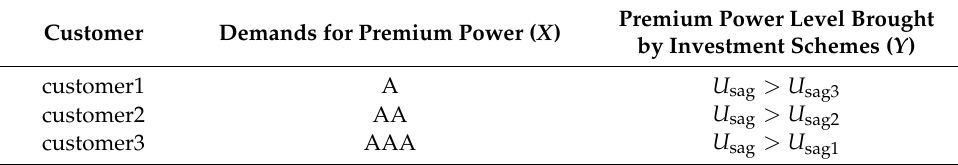
Table 1. The relationship between sensitive customers’ (SCs’) demands, and the premium power level. Customer Demands for Premium Power ( X )